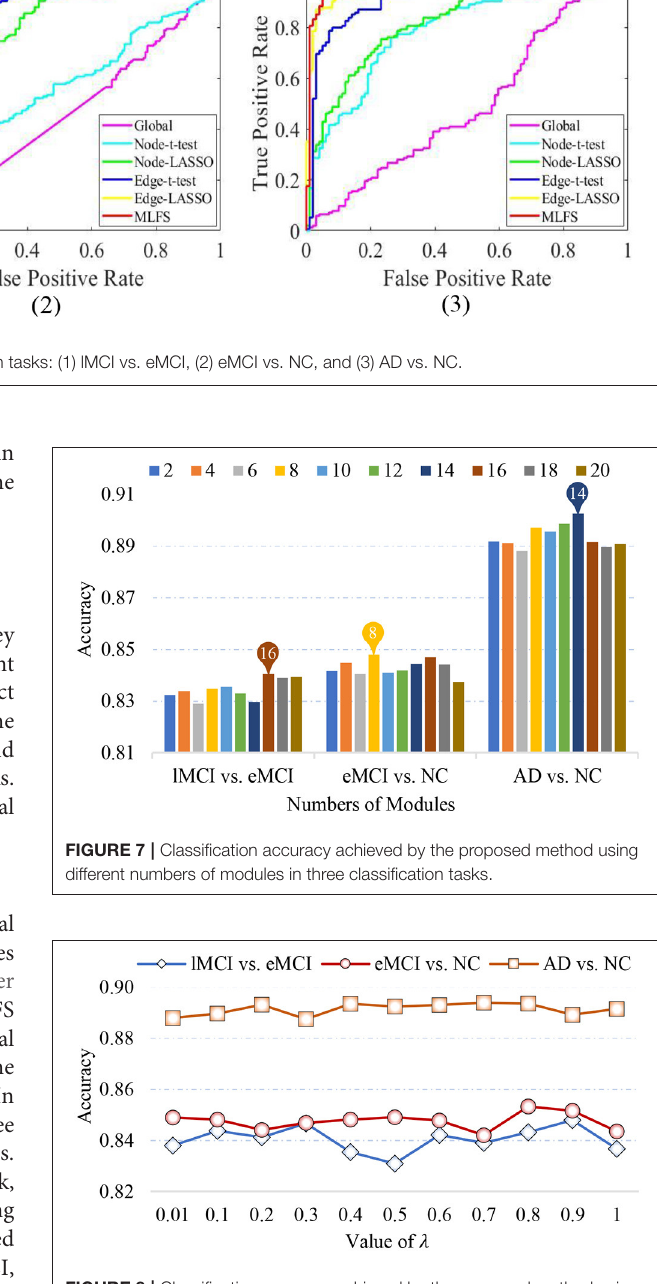
shown in Figure 8 , the MLFS works well with overall stable performance in both tasks of eMCI vs. NC and AD vs. NC classification. In the task of lMCI vs. eMCI classification, the accuracy results slightly fluctuate with different values of λ . Thus, we propose to select the optimal parametric values via inner cross-validation on the training